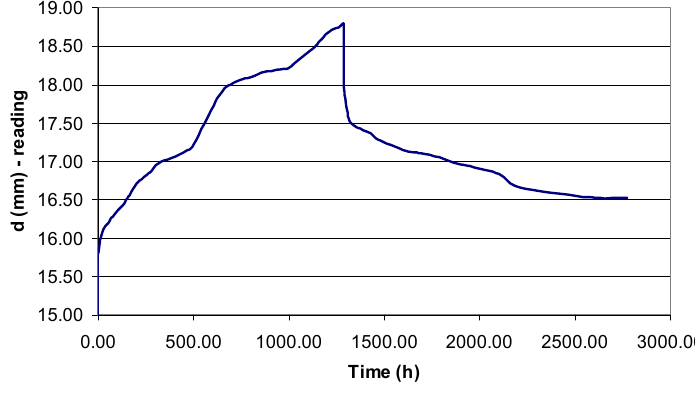
Figure 10: Creep test midpoint deflection vs.